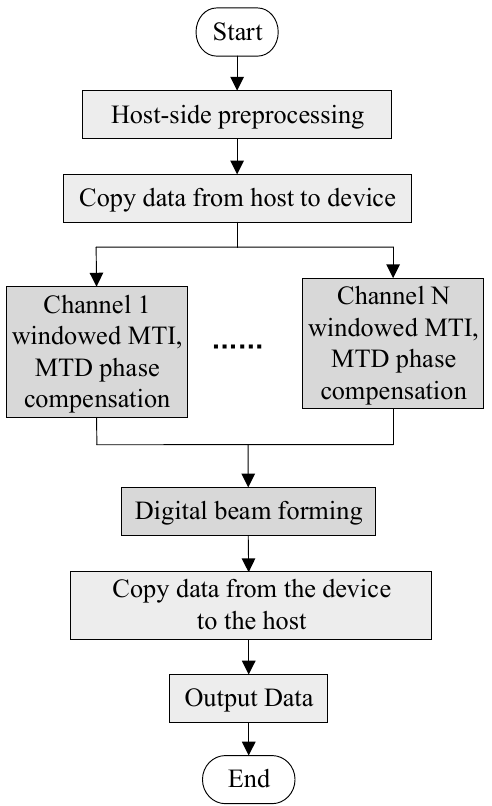
Figure 5. Improved time division MIMO radar GPU processing flowchart.